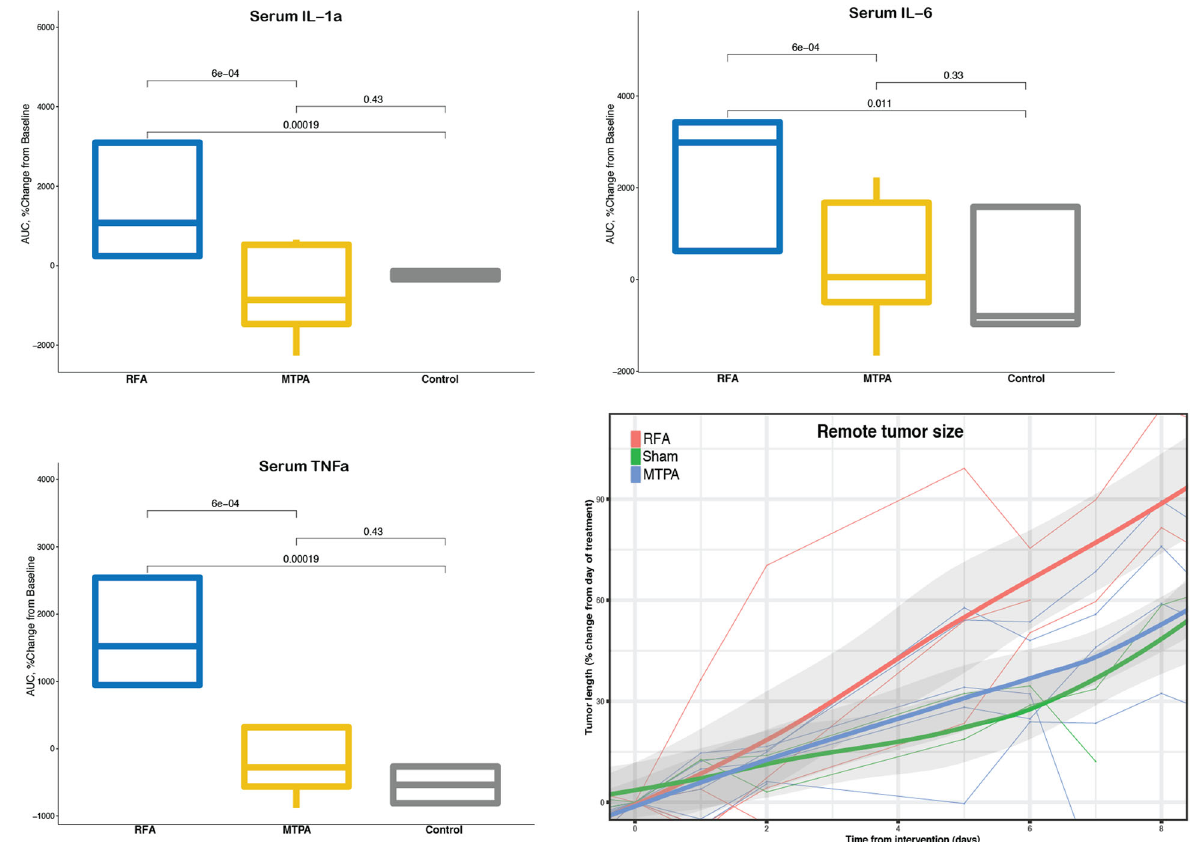
Fig. 6 MTPA decreases systemic oncogenesis relative to RFA. Serum cytokine pro fi ling demonstrated that RFA elaborates signi fi cantly more systemic oncogenic cytokines relative to MTPA or sham surgery. This resulted in accelerated remote tumor growth compared with MTPA or sham. N = 4 animals per group with four independent blood draws per